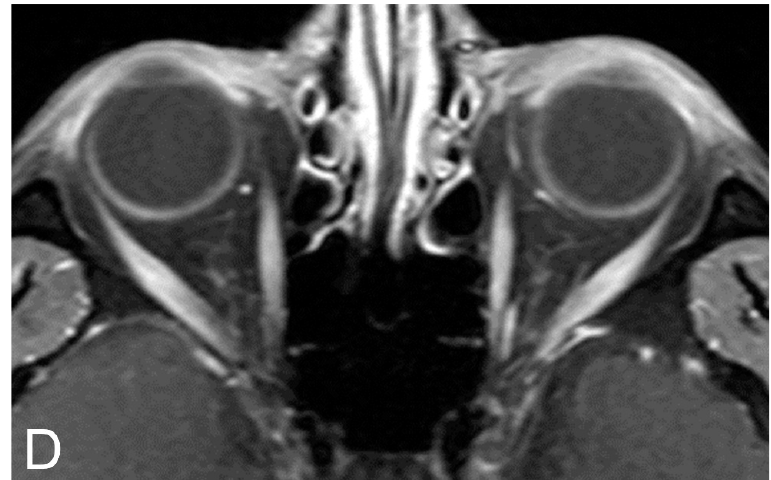
Figure 3. Compressive optic neuropathy. ( A ) Coronal T1 post-contrast MRI sequence shows enlargement of the extra-ocular muscles at the orbital apices (arrows). ( B ) Coronal T1 post-contrast MRI sequence shows the normal appearance of the extra-ocular muscles at the orbital apices. ( C ) Axial T1 post-contrast MRI sequence shows crowding of enlarged extra-ocular muscles with compression upon the optic nerves (white arrows). Note sparing of the tendinous insertions of the extraocular muscles (black arrow). ( D ) Axial T1 post-contrast MRI sequence shows a normal appearance of the extra-ocular muscles.